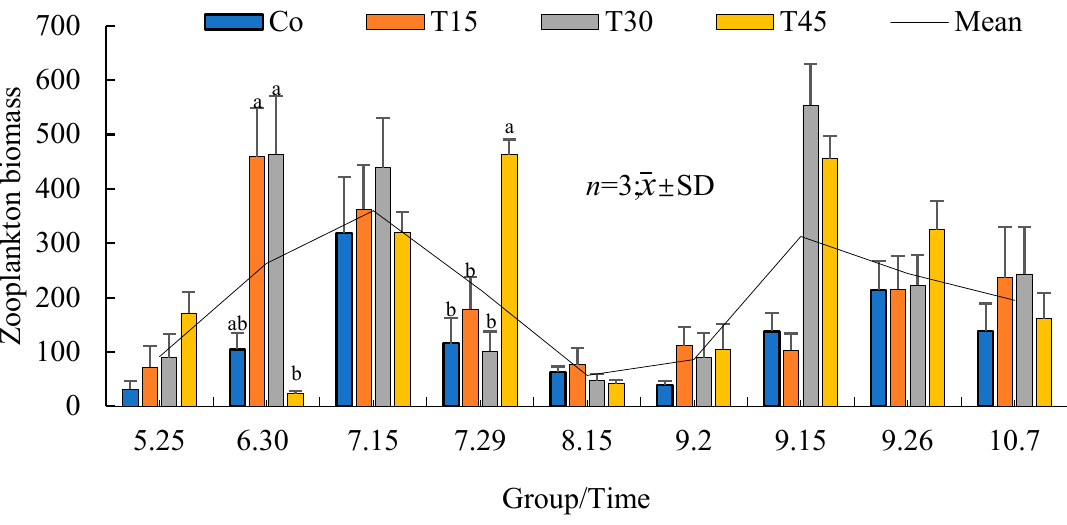
Figure 11. Zooplankton biomass in different treatment groups during the experiment.